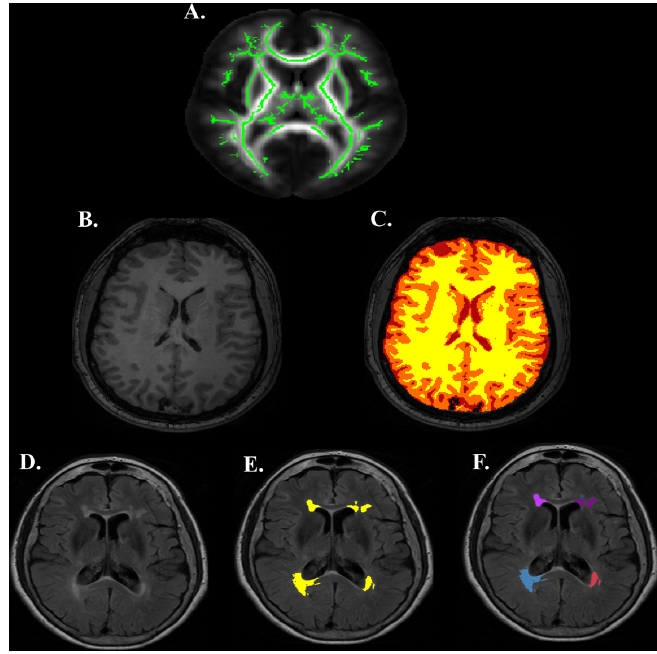
Figure 4. Diffusion and Structural Image Processing Examples. ( A ) Diffusion tensor imaging white matter skeleton. ( B ) T 1 image. ( C ) T 1 image segmented into white matter (yellow), grey matter (orange), and cerebral spinal fluid (red) using SIENAX. ( D ) T 2 -FLAIR image. ( E ) Lesions demarcated (yellow) on T 2 -FLAIR image used for calculating lesion burden. ( F ) Spatially distinct lesions demarcated on T 2 -FLAIR image.